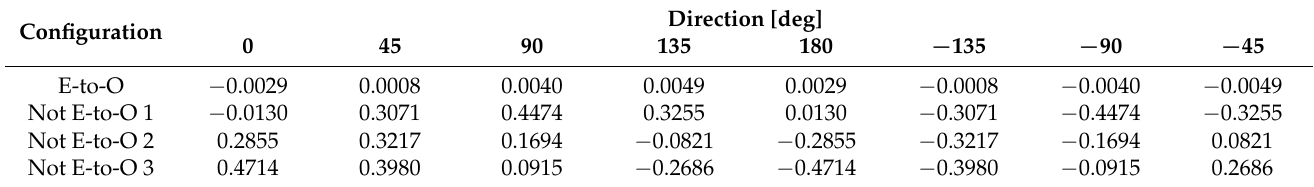
Table 4. Sum of velocity moments per unit command speed [m]—4-wheeled Omni wheel robots.